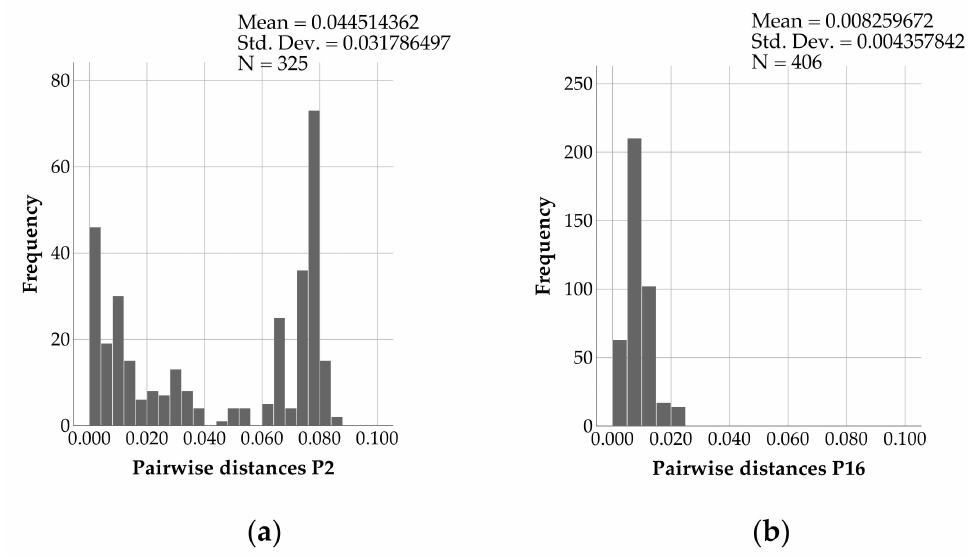
Figure 7. Pairwise distances within norovirus ( a ) GII.2[P2] and ( b ) GII.2[P16] sequences calculated by Jukes Cantor method in